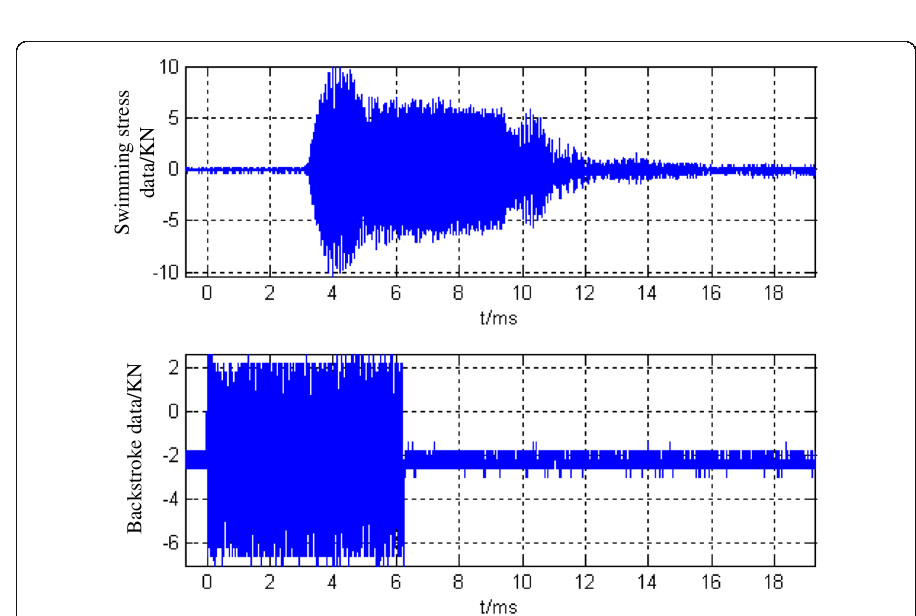
Fig. 2 Results of swimming mechanics